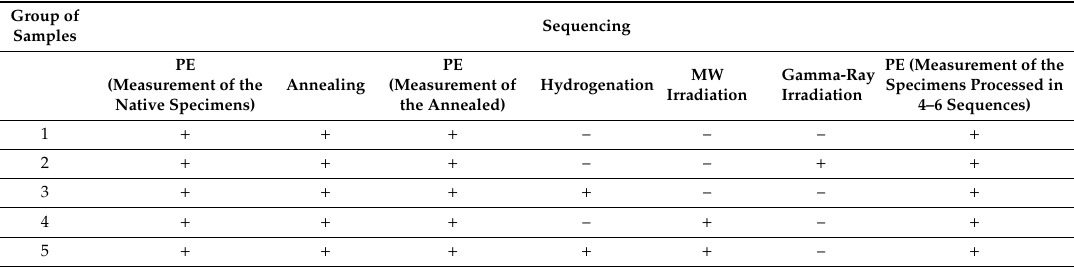
Table 6. The plan of the